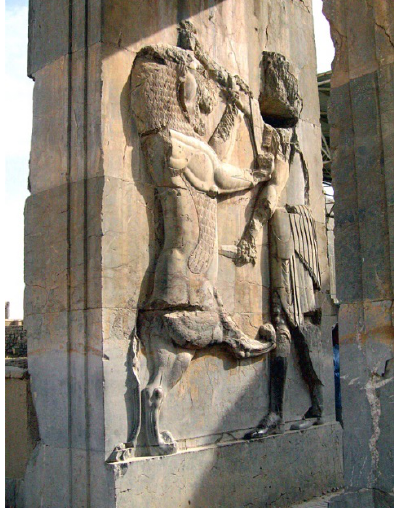
Figure 25. Royal hero fighting and stabbing a lion; south jamb of the southern doorway in the western wall, Throne Hall, Persepolis, Persia (mod. Iran); Achaemenid, ca. 522–465 BCE [photography by Mary Loosemore; used with permission].